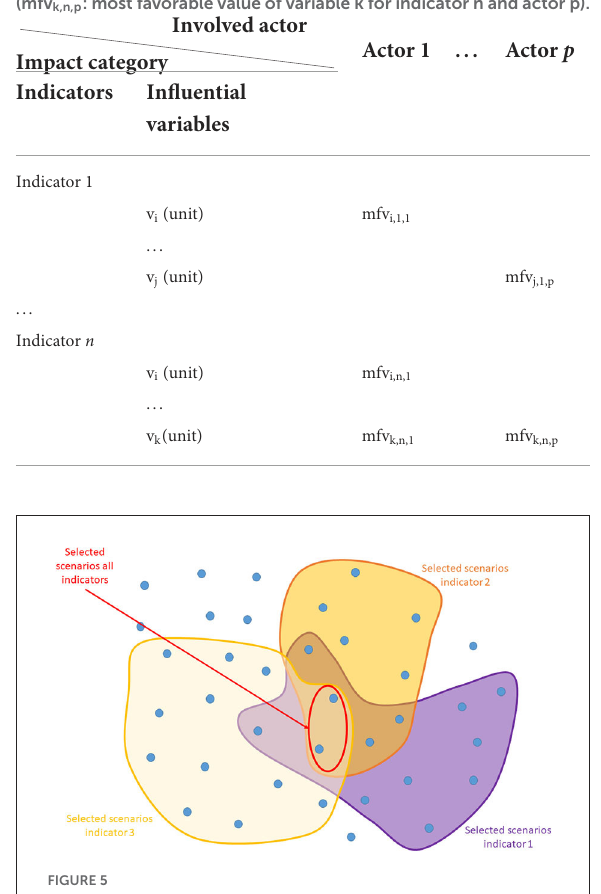
TABLE 4 Example of results obtained from global sensitivity analysis (mfv k,n,p : most favorable value of variable k for indicator n and actor p).